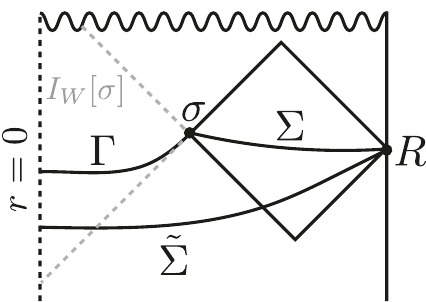
˜ M, ˜ g ) containing D [Σ] . The maximal volume slice